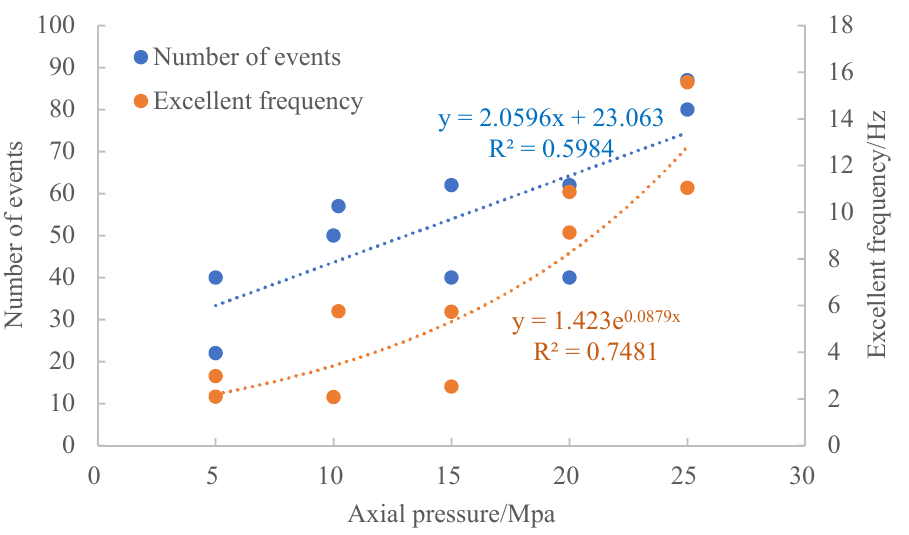
Figure 13. Relationship of the number and average excellent frequency of infrasound events with axial pressure.